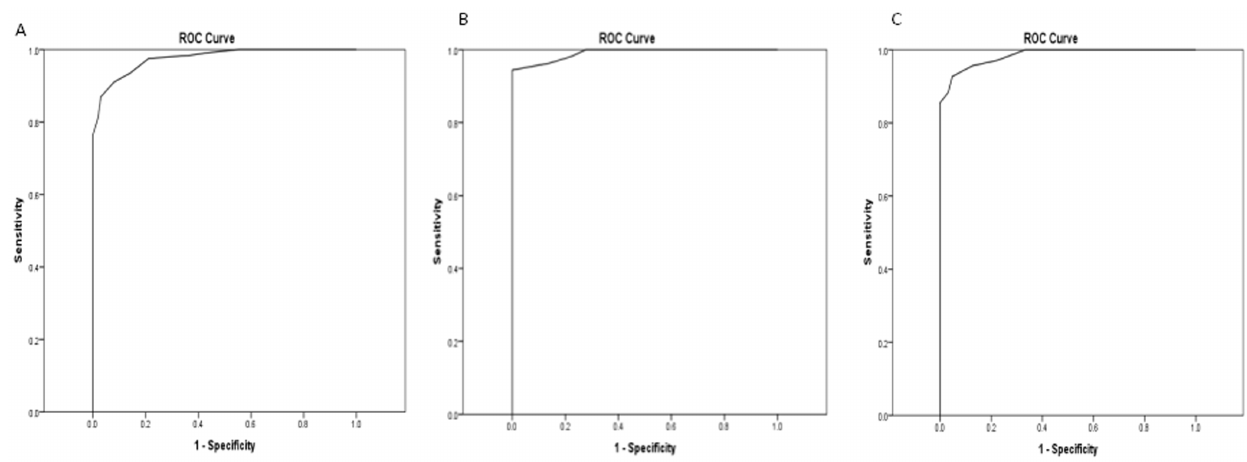
Figure 2. Receiver operator characteristic curves to identify mutation patients with a GCK mutation from controls using HbA1c. (A) all ages AUC 0.97 (B) # 40 years of age AUC 0.99 (C) . 40 years of age AUC 0.98.